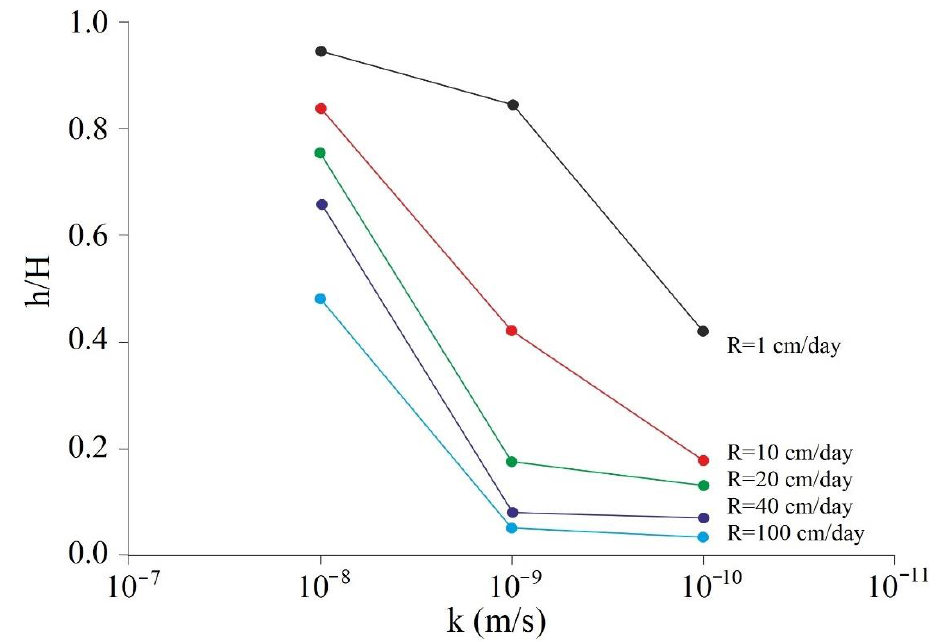
Figure 5. The Dependency of a drawdown on the permeability coefficient with different discharge